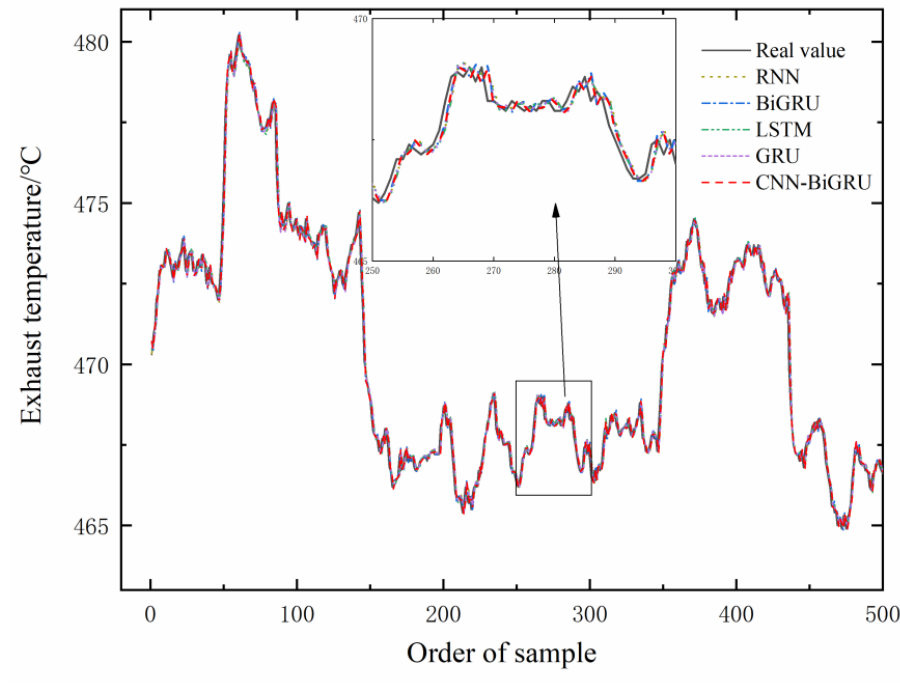
Figure 7. Comparison results from different models. Table 6. Evaluation index of prediction results of different models.